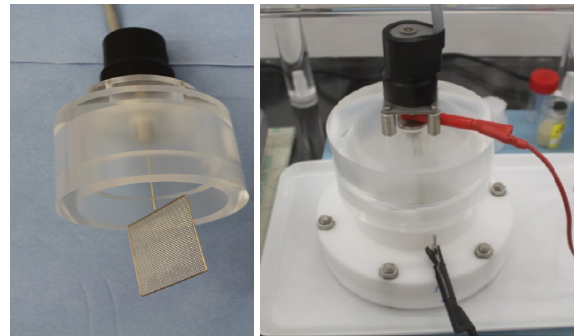
Fig. 3. Pictures of the molecular plating cell; left part: new upper part with Pt anode, right part: cell connected to power